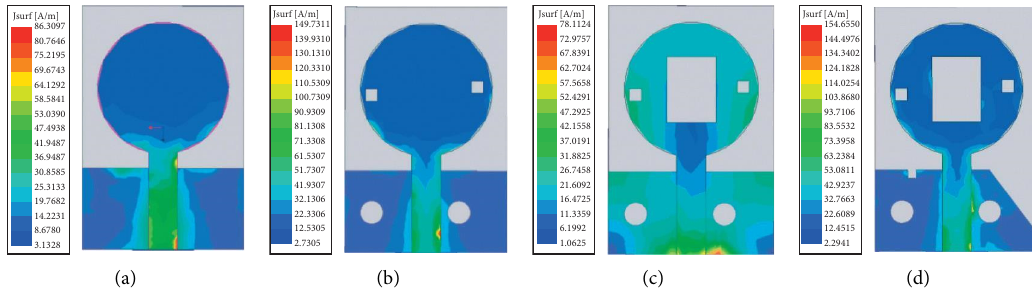
Figure 6: Simulation results of the current distribution of the UWB antenna with a phase of 0: (a) stage 1, (b) stage 2, (c) stage 3, and (d) stage 4.